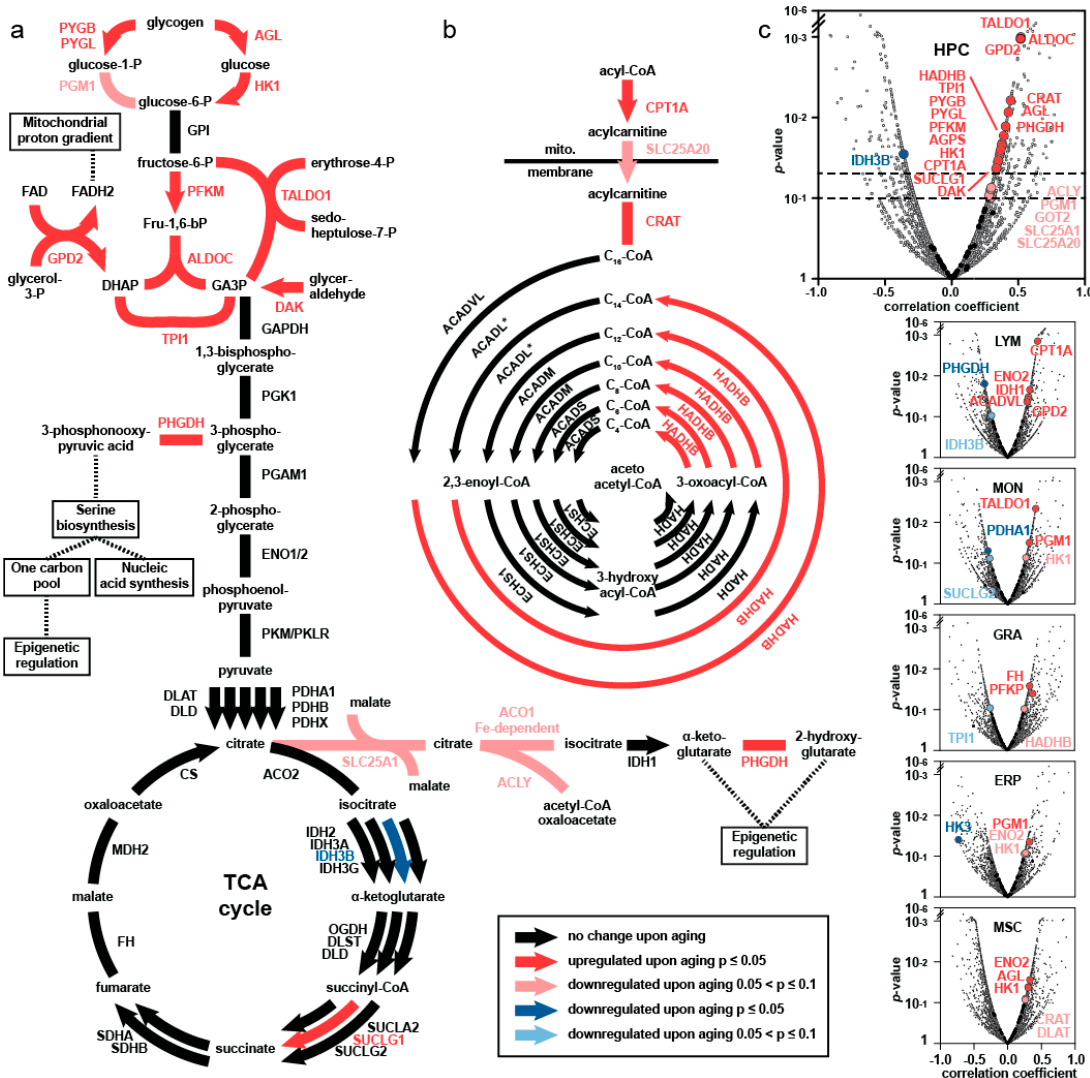
Figure 2. Changes in central carbon metabolism of HSPC upon aging (modified from Hennrich et al. [23]). ( a ) Glucose metabolism pathway and the tricarboxylic acid (TCA) cycle are depicted. The respective enzymes are shown in capital letters and the color encodes for changes upon aging. Glycogen is broken down and the products are fed into glycolysis. Glucose-6 phosphate is metabolized to dihydroxyacetone-phosphate (DHAP) and glyceraldehyde-3-phosphate (GA3P). The enzymes GPD2 and DAK that feed the pool of DHAP and GA3P increase upon aging as well as TALDO1. ( b ) A specific set of enzymes involved in the mitochondrial beta-oxidation of fatty acids increase in abundance with age. ( c ) Volcano plots of all proteins quantified in the respective cell populations. The elevation of enzymes involved in the central carbon metabolism is found only in the HSPC.